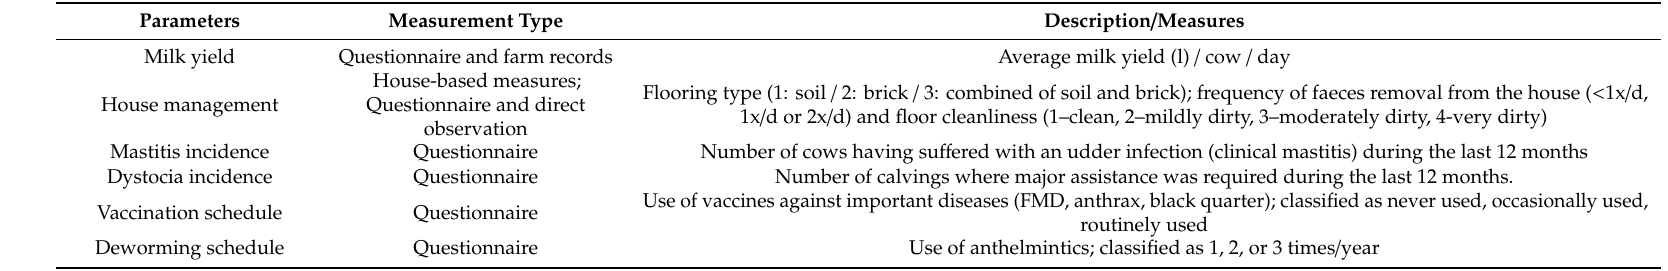
Table 1. Parameters measurement and methodology of data collection for the assessment of milk yield and health of the selected dairy cows based on management parameters used in the Welfare Quality ® assessment protocol (Welfare Quality ® ,